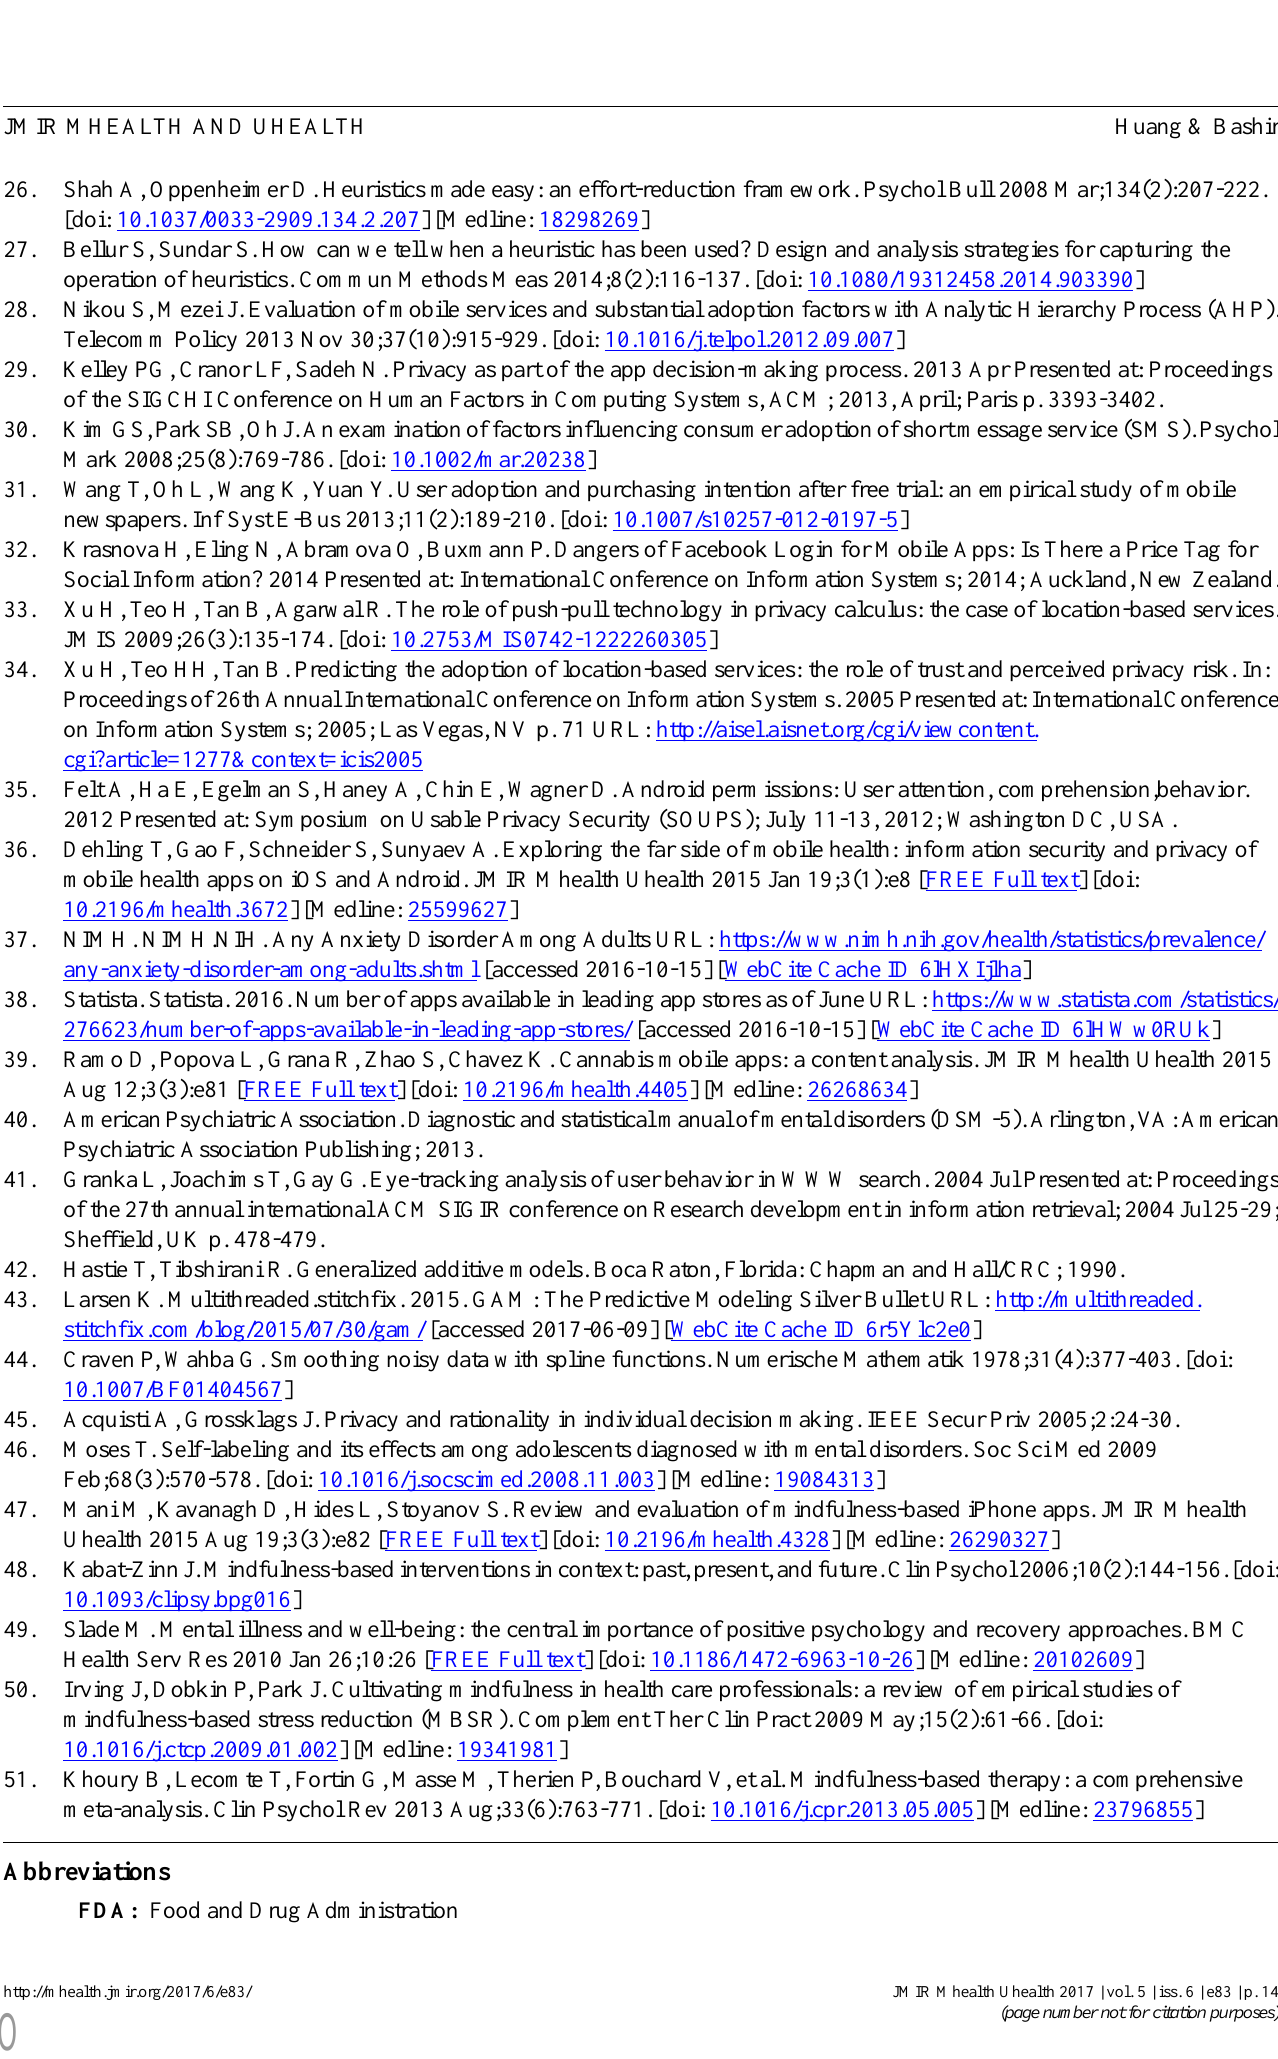
FDA: Food and Drug